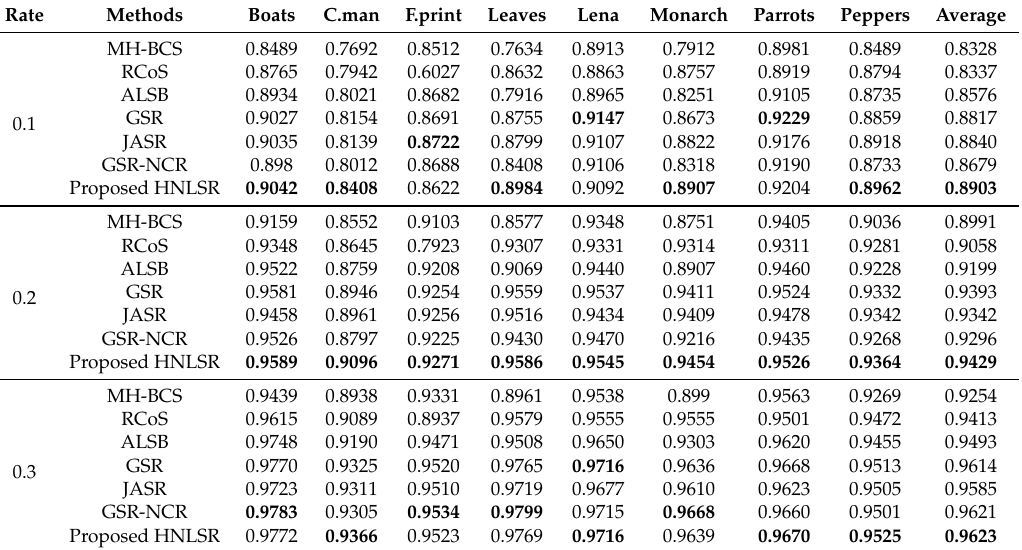
Table 2. FSIMcomparison of six representative methods and the proposed